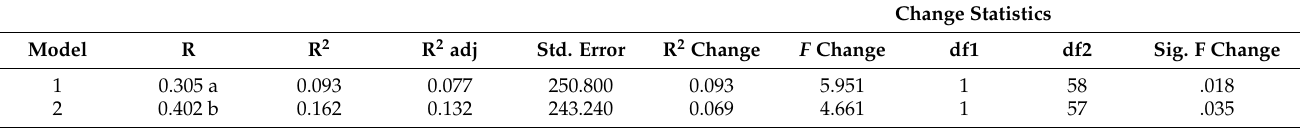
Table A5. Model summary for word RTs T3.